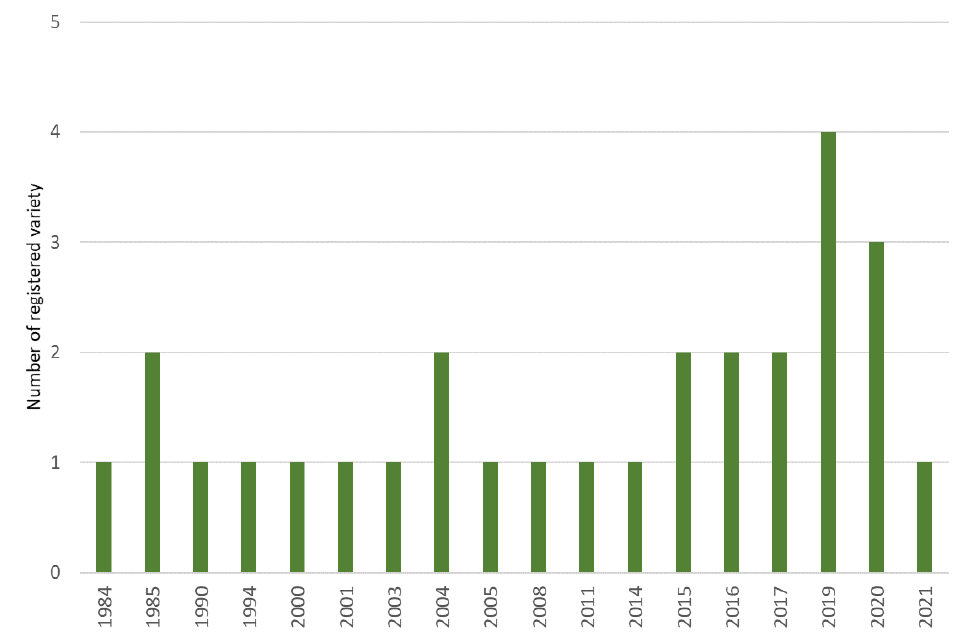
Figure 15. Number of white lupin varieties according to registration year from the national variety lists of the EU member states [47–64].